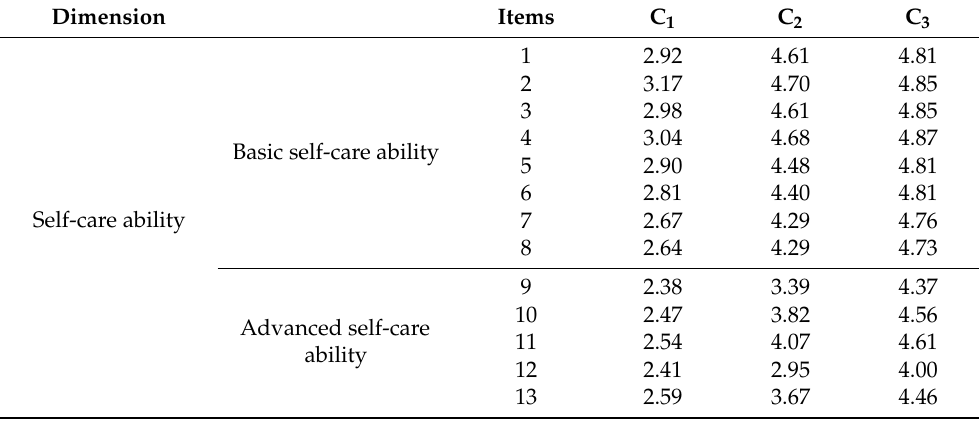
Table 6. The 45-item response mean of the self-supporting ability scale of the three